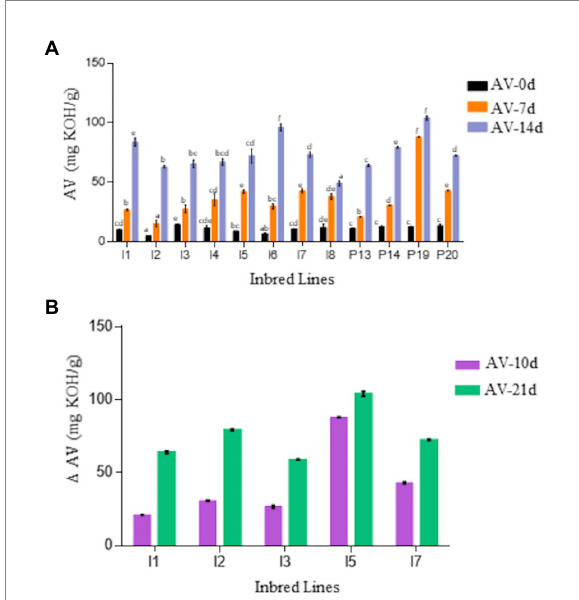
FIGURE 1 (A) Comparison of acid value (AV) of flour of 12 pearl millet inbred and germplasm association lines (PMiGAP) during 14-day accelerated storage conditions. The genotypes include ICMB- 843 (I1); ICMB-88004 (I2); ICMB-95222 (I3); ICMB-81 (I4); ICMB- 89111 (I5); ICMP-842 (I6); ICMB-863 (I7); ICMB-98222 (I8); IP5931 (P13); IP13840 (P14); IP 22419 (P19); IP6099 (P20). (B) Change in AV in the flour of selected contrasting lines on day 10 and 21. The data are represented as the mean ± standard error of three biological replicates. Variables showing F -value less than 0.05 were significant. Also, the means displaying non-matching lowercase letters were significantly different at p ≤ 0.05 by the Duncan